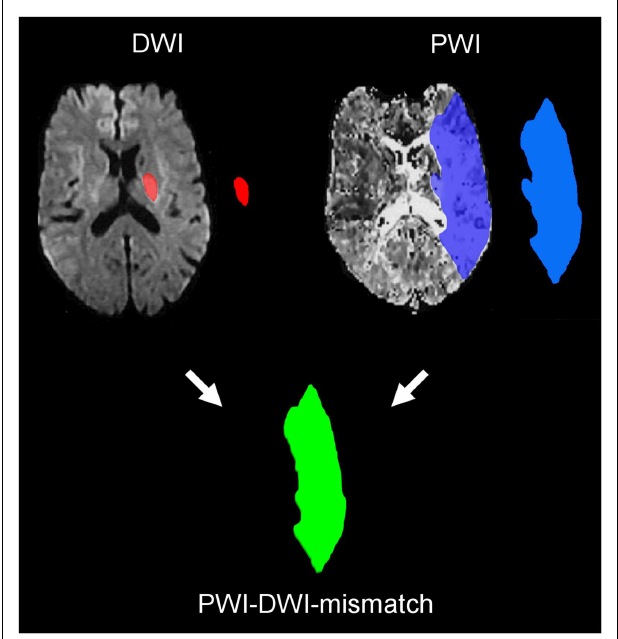
FIGURE 1 | MRI perfusion–diffusion mismatch .The small lesion on diffusion weighted imaging (DWI) represents the infarct core, while the much larger area in the time to peak map calculated from perfusion imaging (PWI) identifies the area of critically hypoperfused tissued.The mismatch between both volumes represents the tissue at risk of infraction and thus, the target tissue for reperfusion